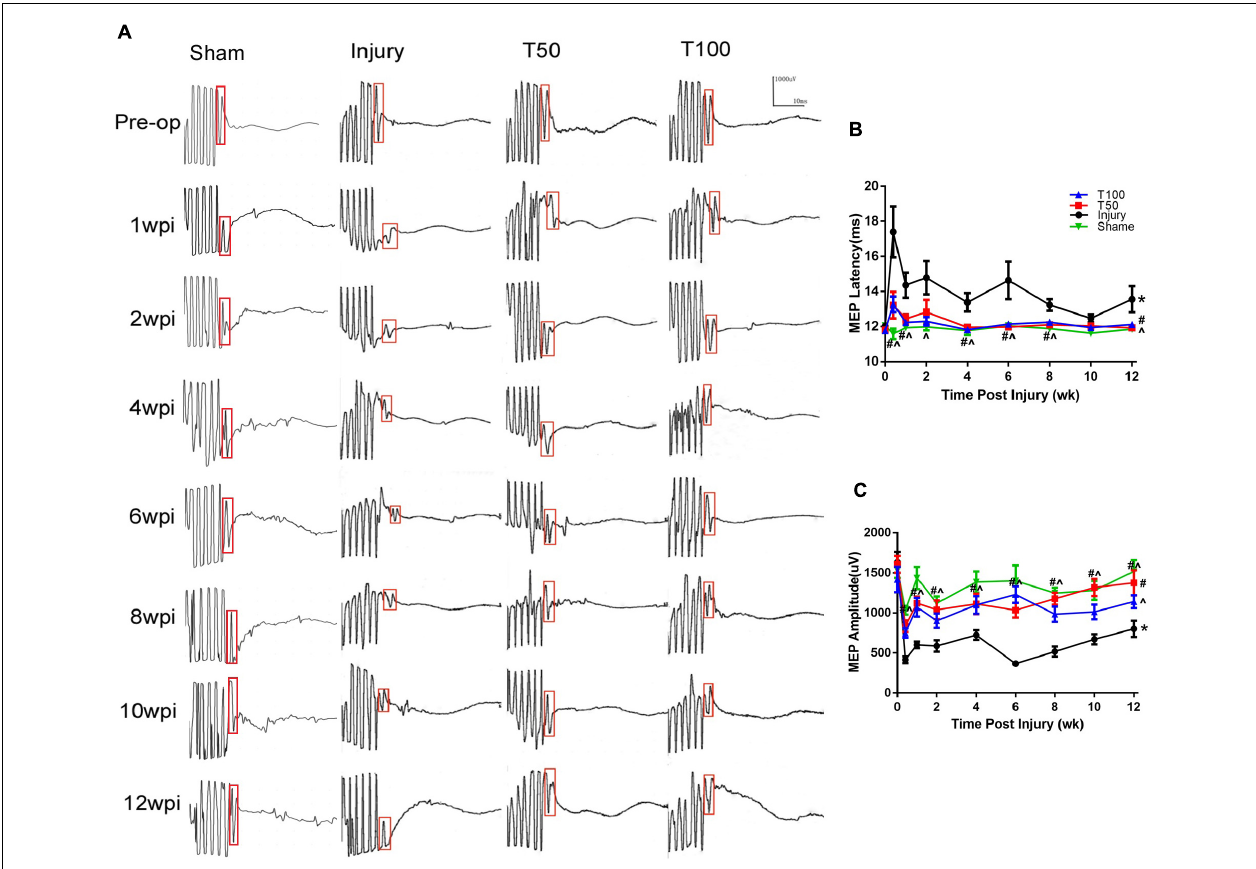
FIGURE 5 | Motor evoked potentials (MEPs) results. (A) MEPs waveforms preoperative and postoperative. (B) MEPs latency; (C) MEPs amplitude. * P < 0.05, comparison between each group and the sham group; # P < 0.05, comparison between T50 group and injury group; ∧ P < 0.05, comparison between T100 group and injury